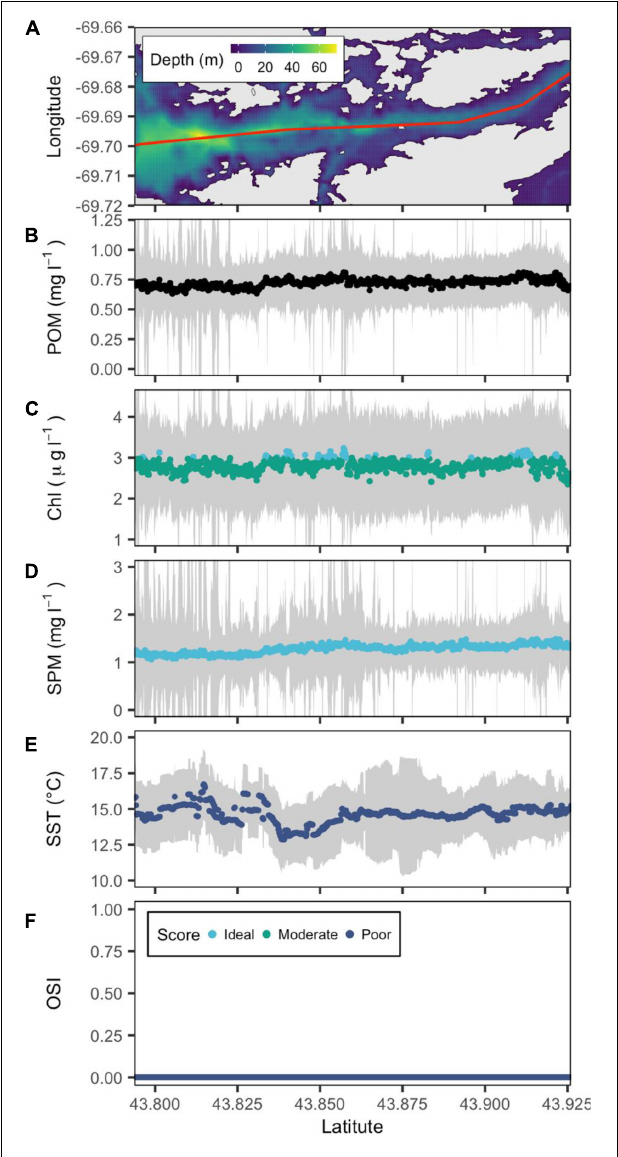
FIGURE 4 | Bathymetric map of the Sheepscot River estuary (from downstream to upstream left to right) with a red line showing the central transect. (A) POM (B) , SPM (C) , Chl a (D) , and SST (E) are reconstructed from remote sensing data, and OSI (F) is derived following the method of Snyder et al. (2017). Gray color belts show standard deviation of POM, SPM, Chl a, and SST derived in summer (June–September) over the period 2016–2020, with their median values depicted by blue, green, and cyan points that denote poor, moderate and ideal conditions for oyster aquaculture,